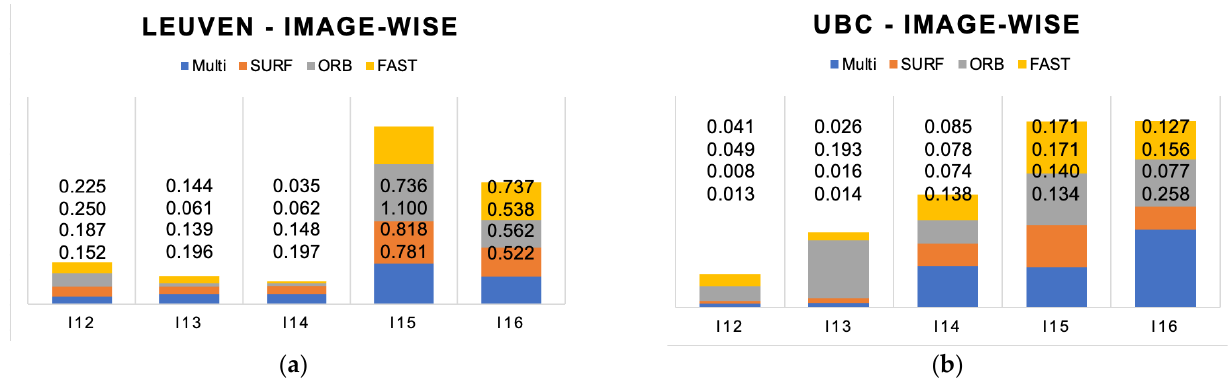
Figure 10. Pairwise RMSE [m] evaluation of H-matrix estimation of Leuven ( a ) and Ubc ( b ). The average RMSE evaluation of H-matrix estimation and the average number of features detected for both, Leuven and Ubc, are summarized in Table 5. SURF and multi- FDO can both achieve 0.37 m ( − +0) for the Leuven scene. However, SURF detects 3760 pt whereas this study’s multi-FDO detects 10,840 pt (+188%). On the Ubc JPG compression case, SURF realizes 0.062 m and detects 3681 pt. Our multiple FDO approach achieves